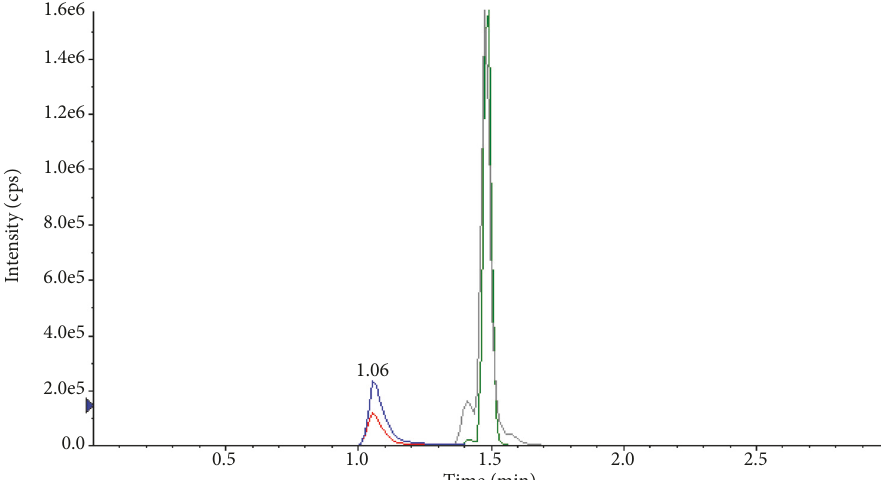
Figure 3: Chromatogram of analytes/ISTDs with high base line noise (liquid-liquid